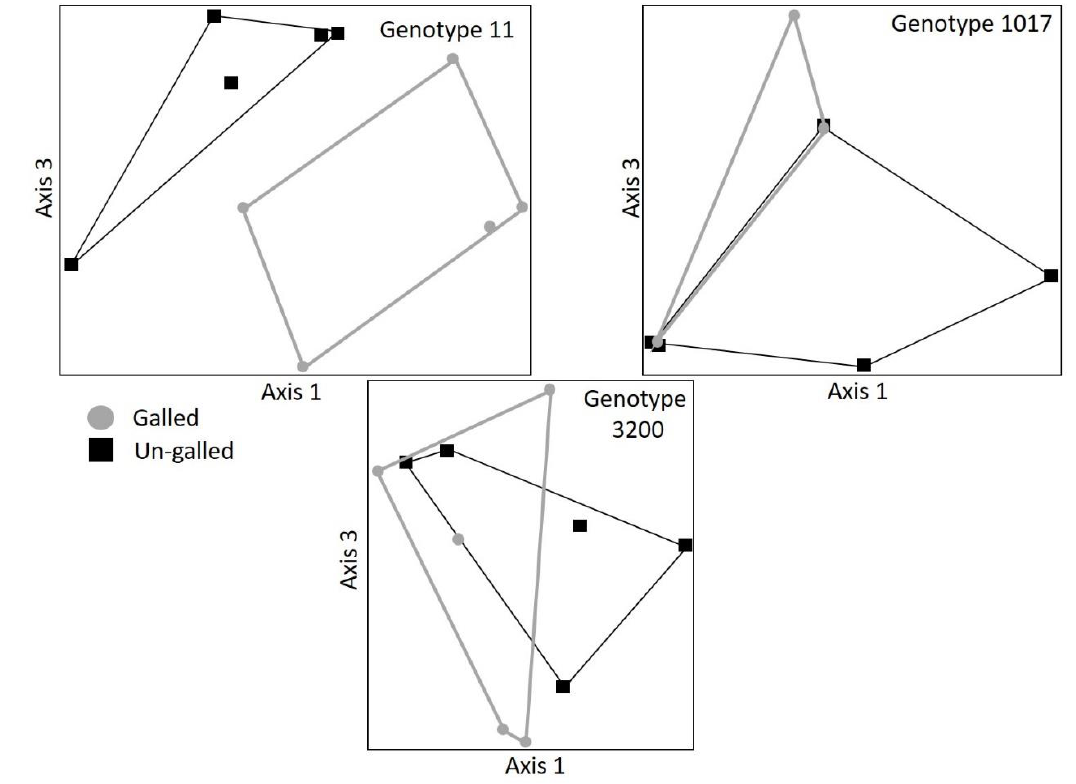
Figure 4. NMDS ordinations showing a distinct di ff erence macroinvertebrate community structure between galled and un-galled litter for one of three backcross hybrid cottonwood genotypes (MRPP results 11: A = 0.0486, p = 0.0405; 1017: A = − 0.0335, p = 0.8058; 3200: A = − 0.0391, p = 0.9198). Symbols represent entire macroinvertebrate communities on galled ( • ) versus un-galled ( (cid:4) ) litterbags. We found no di ff erences in invertebrate species richness, evenness or diversity indices (H’